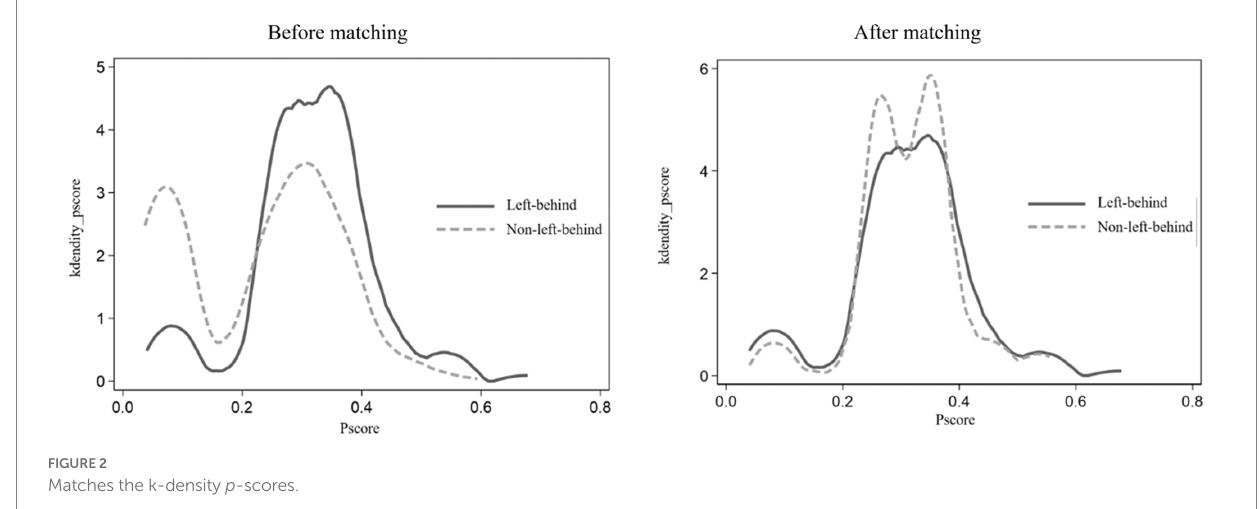
FIGURE 2 Matches the k-density p -scores.